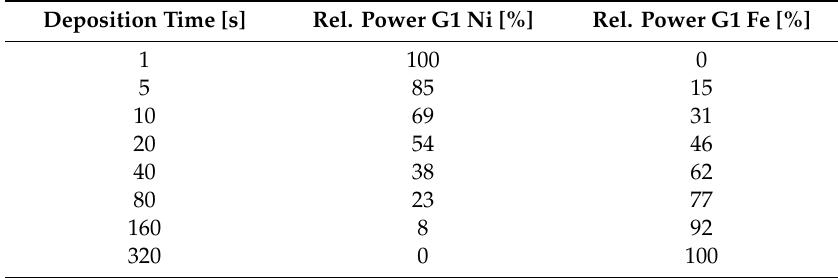
Table 2. Parameter levels for the nanoparticle deposits used in the alkaline water electrolysis experiment. The Ni / Fe ratio in the deposit was varied by adjusting the relative power of the two spark generators, keeping the total power